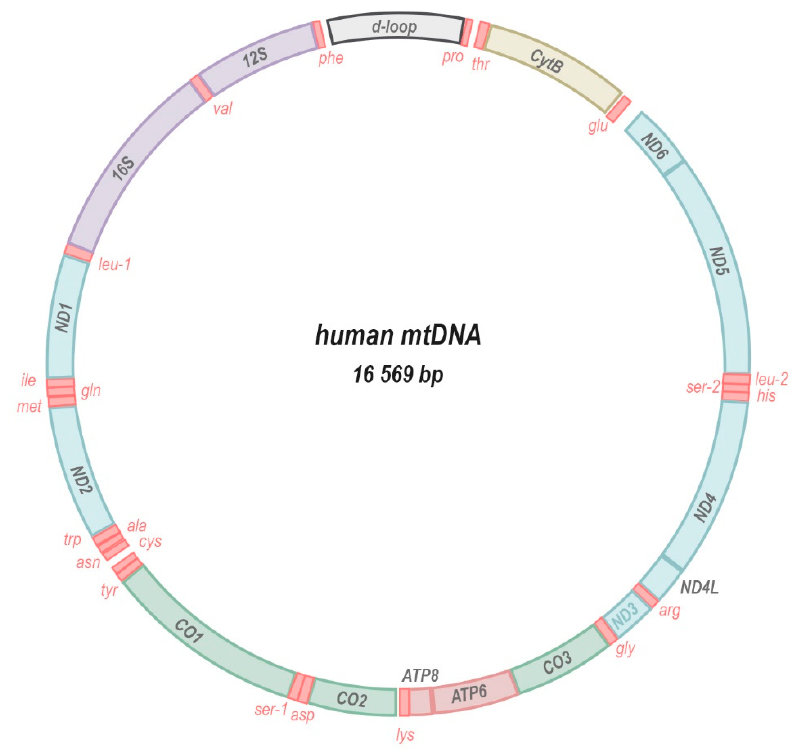
Figure 2. The mitochondrial DNA (mtDNA). The mtDNA molecule encodes 13 crucial protein subunits of the electron transport chain (blue, yellow, green) and ATP synthase (muted red), 2 rRNA components of the mitoribosome (purple) and 22 mitochondrial tRNAs (bright red). Very little intergenic space separates the genes that are transcribed as a polycistronic transcript and also contain no introns. The regulatory region, called D-loop, comprises sites for the initiation of replication and transcription of the mtDNA.